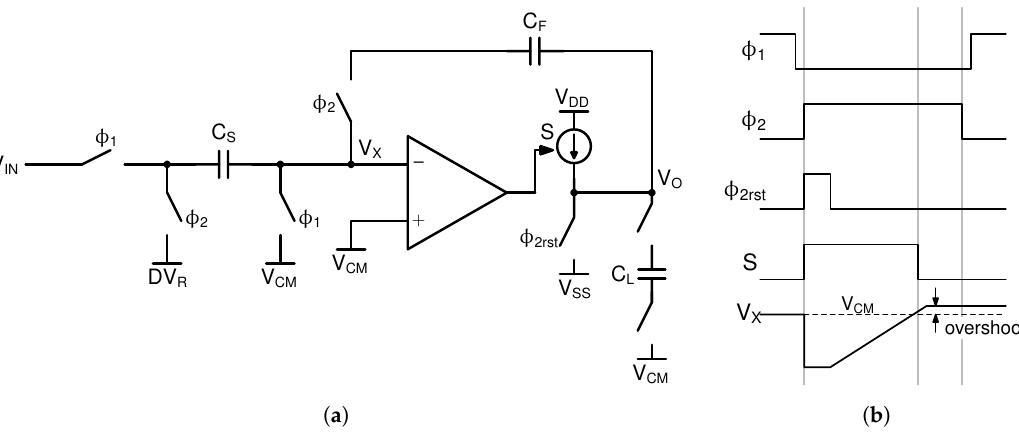
Figure 1. Conventional zero-crossing-based switched-capacitor circuit. ( a ) Schematic diagram. ( b ) Timing diagram.